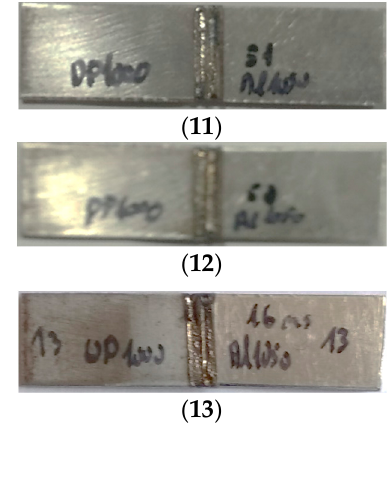
Figure 8. Solidified sample after injection of epoxy resin + hardener.